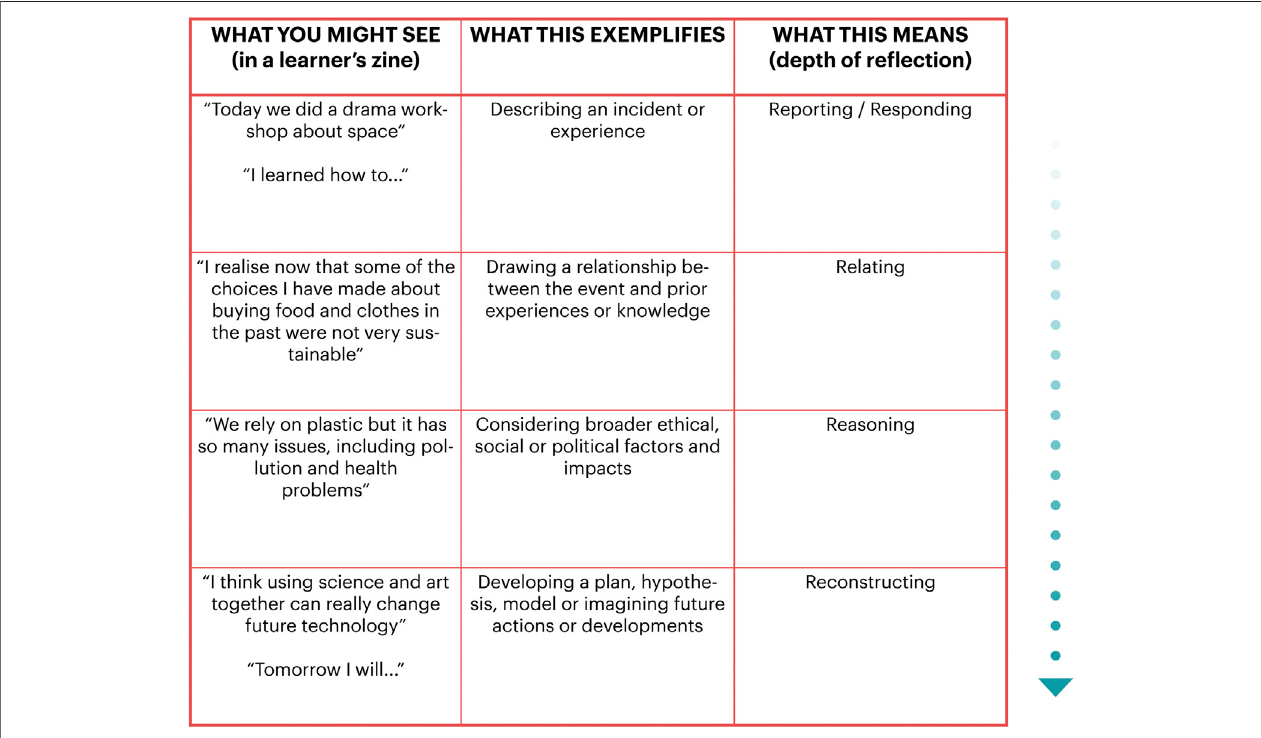
FIGURE 2 | Re fl ection framework to evaluate re fl ection in zines, based on Ryan and Ryan 4Rs (2015) including levels of re fl ection and textual